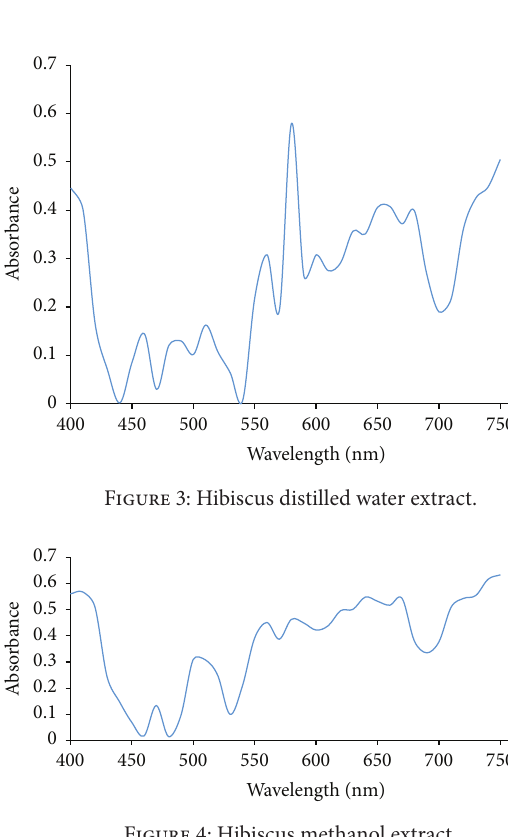
Figure 4: Hibiscus methanol extract.